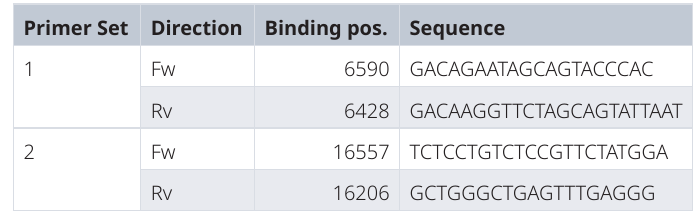
Table 3. Targeted locus amplification